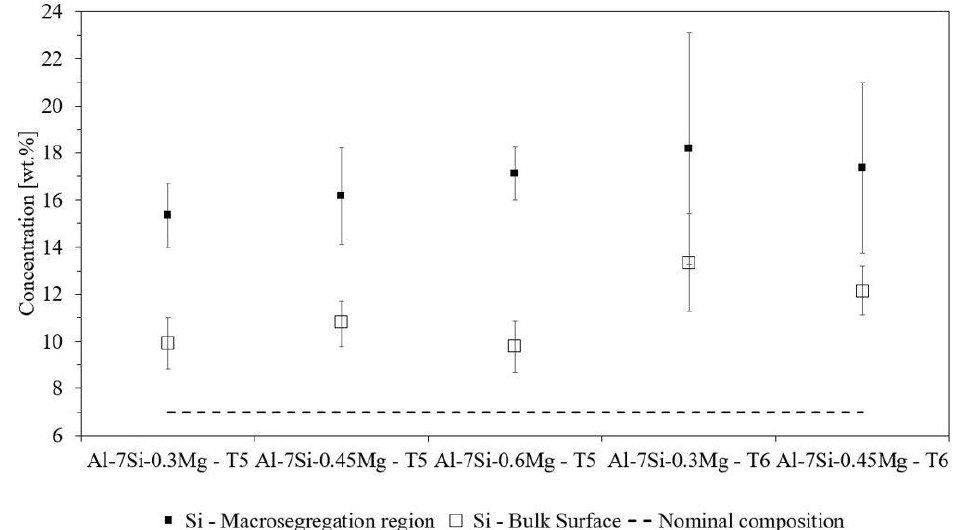
Figure 9. Optical micrographs showing regions of macrosegregation on the first 190 µm surface layer of ( a ) SSM Al – 7Si – 0.3Mg and ( b ) SSM Al – 7Si – 0.6Mg castings in the T5 condition and ( c ) SSM Al – 7Si – 0.45Mg casting in the T6 condition. 1 — Region of positive macrosegregation. Arrows indi- cate the possible location of oxide films. The dashed line shows the die wall position during casting.